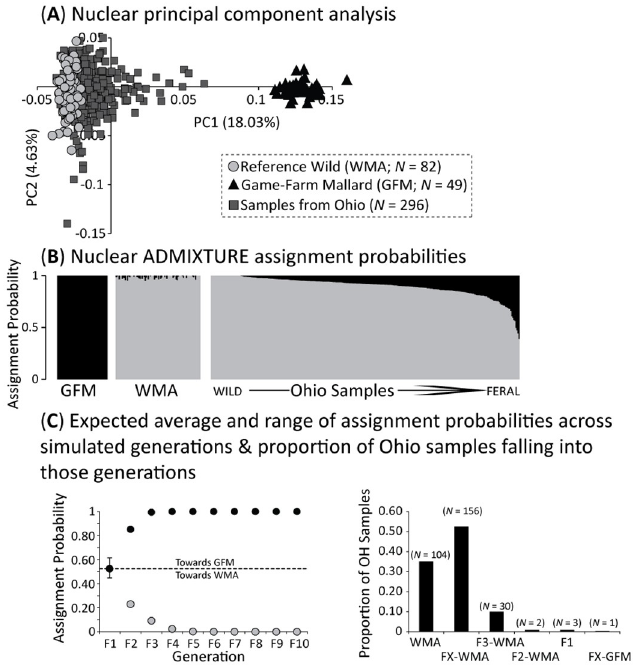
Fig 2. Population structure analyses based on 22,136 independent bi-allelic ddRAD-seq SNPs assayed across Ohio (OH) samples, as well as reference wild (WMA) and game-farm (GFM) mallards, including (A) a plot of the first two principal components of the principal components analysis (PCA) and (B) ADMIXTURE assignment probabilities attained under an optimum K populations of 2 (S2B Fig). Finally, we provide the (C) expected average and range of assignment probabilities across simulated generations (left), as well as the proportion of Ohio samples falling into those generations (right).